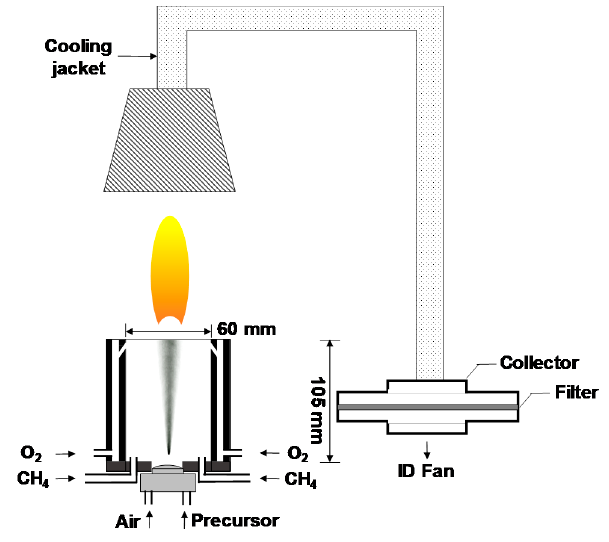
Figure 1. Experimental setup for flame spray pyrolysis (FSP).